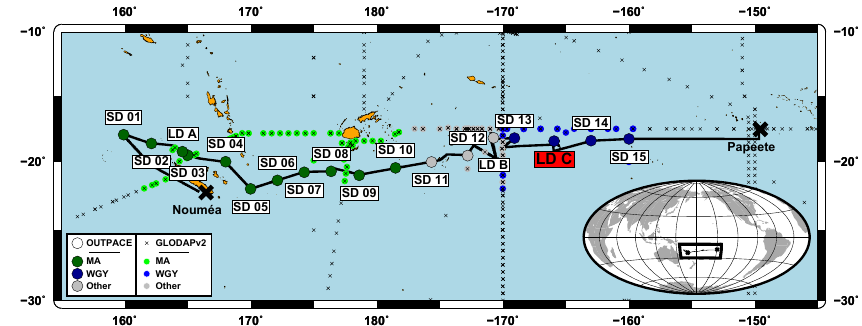
Figure 1. Map of the OUTPACE cruise transect. Melanesian Archipelago (MA) stations are indicated by large dark green large dots and the western gyre (WGY) stations by large dark blue dots. Stations outside of these two areas are in gray. The station in red corresponds to the station where the deep cast and intercomparison cast were made. Stations from the GLODAPv2 database are indicated with small crosses: small green dots correspond to GLODAPv2 stations considered for comparison in the MA area; small blue dots correspond to GLODAPv2 stations considered for comparison in the WGY area and small gray dots are the other GLODAPv2 stations considered for